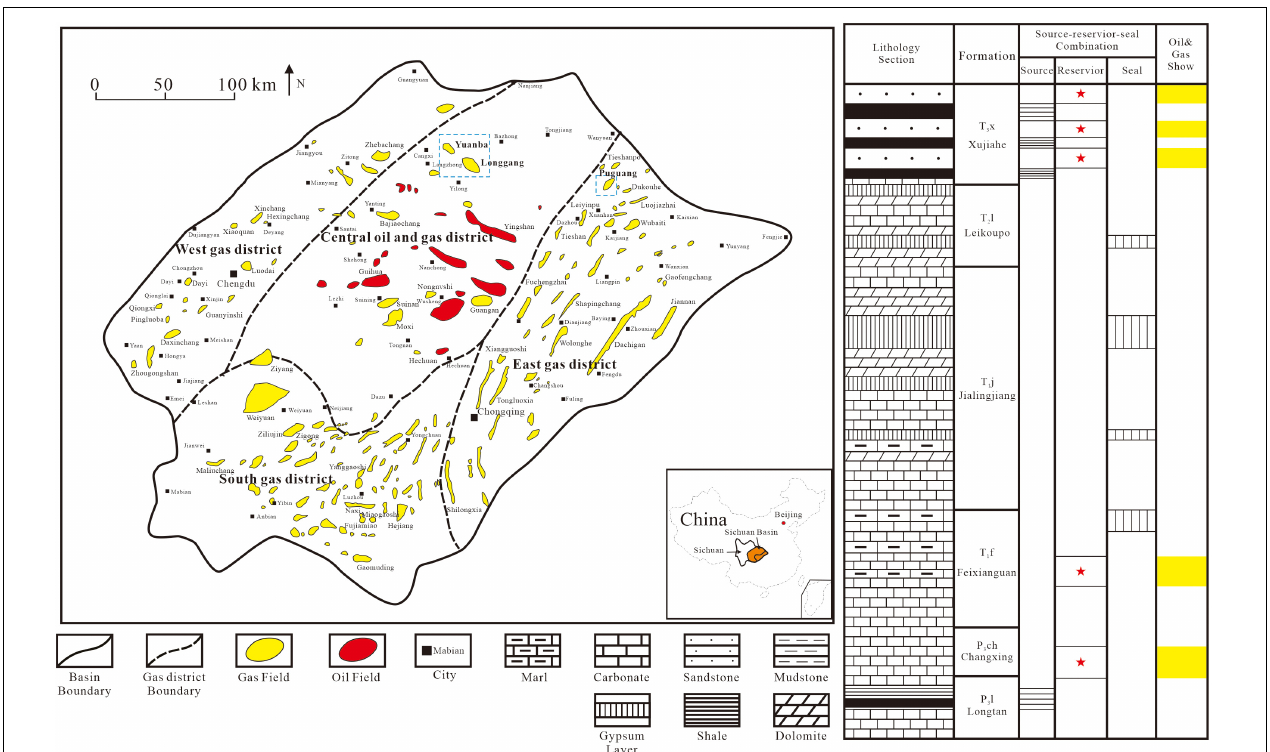
FIGURE 2 | Location map of the Puguang, Yuanba and Longgang gas fields in the Sichuan Basin, the stratigraphic column and source-reservoir-seal combination (Dai et al., 2012a; Qin et al., 2016). Reservoir layer is marked as